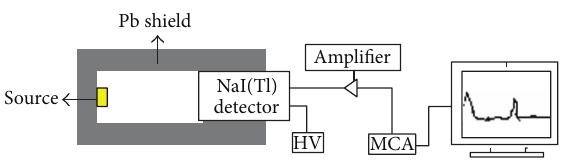
Figure 1: Schematic view of the experimental system.